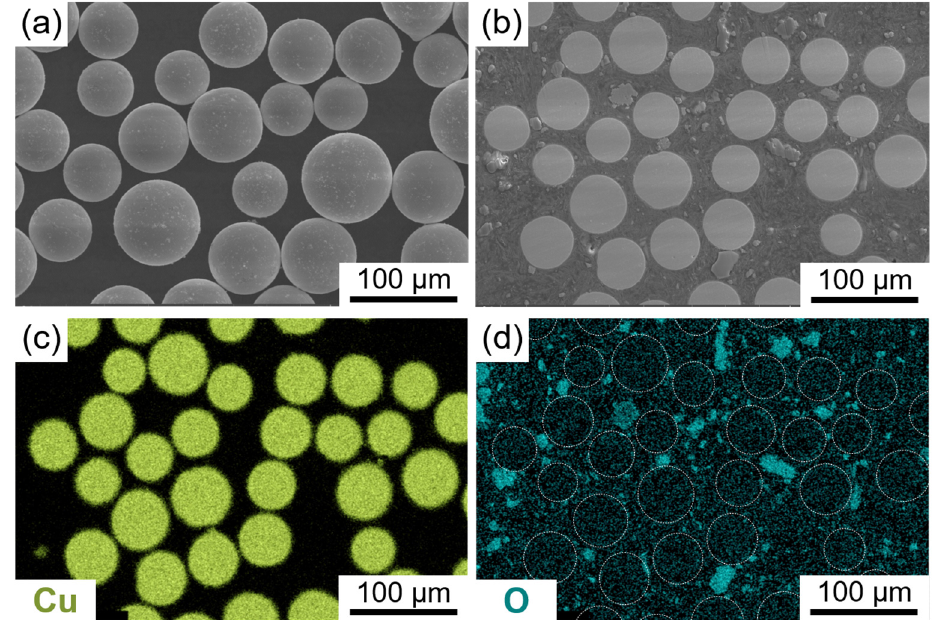
Figure 10. Morphology of the CS-powder: ( a ) SEM image, ( b ) SEM image of the cross-section; ( c ) Cu distribution and ( d ) O distribution.